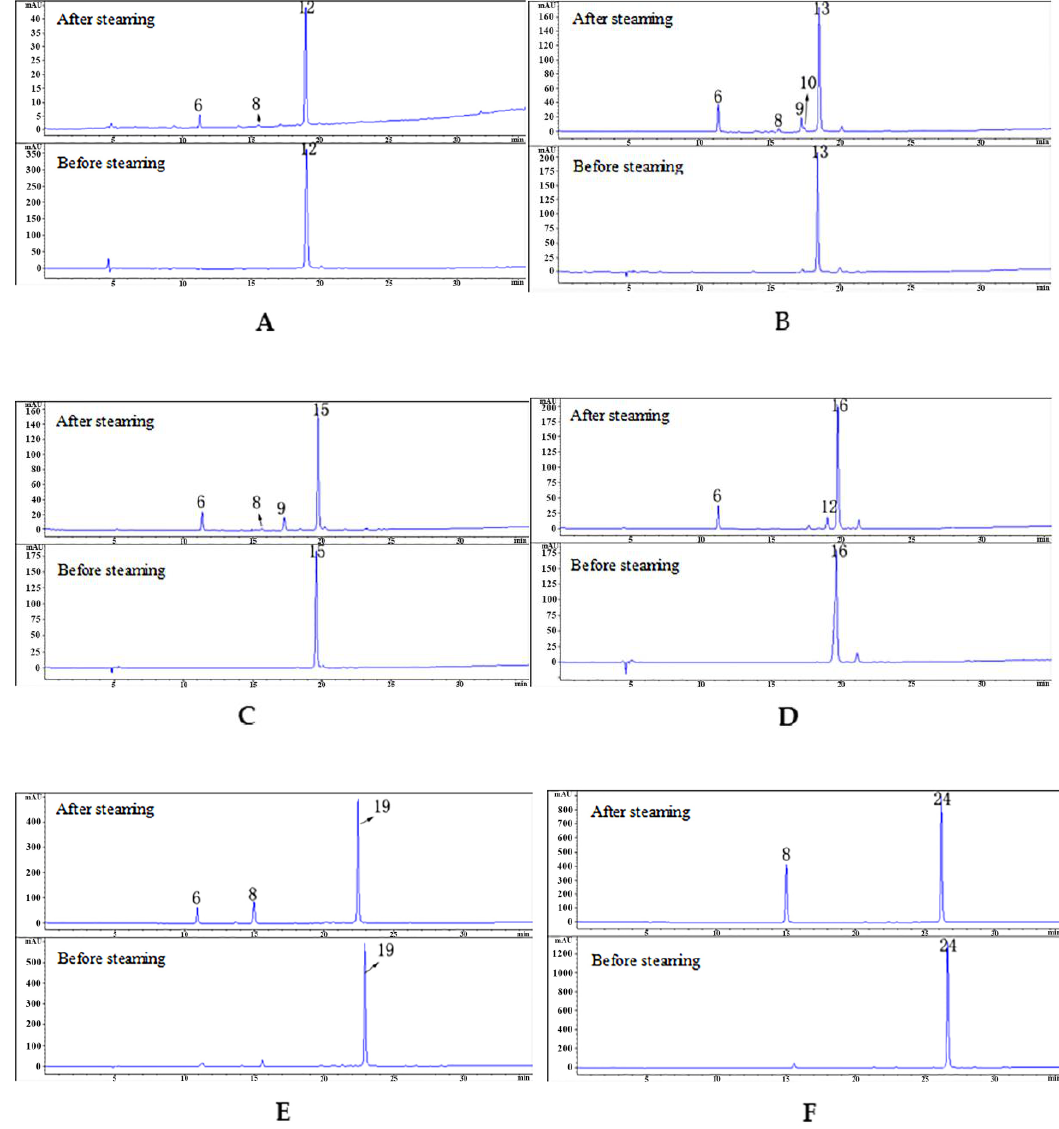
Figure 6. The HPLC chromatograms of compounds PJ ( A ), PB ( B ), PC ( C ), PK ( D ), gastrodioside ( E ), 4,4’-dihydroxydibenzyl ether ( F ) after hydrolysis. Compounds of GAS, HBA, S -(4-hydroxybenzyl)glutathione were still stable after hydrolysis